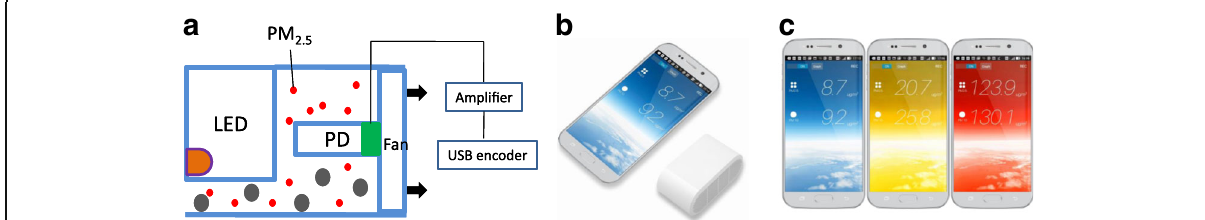
Fig. 1 Pocket PM 2.5 Sensor. a Principle of Pocket PM 2.5 Sensor Module, LED, light-emitting diode; PD photodiode; USB, Universal Serial Bus. b Pocket PM